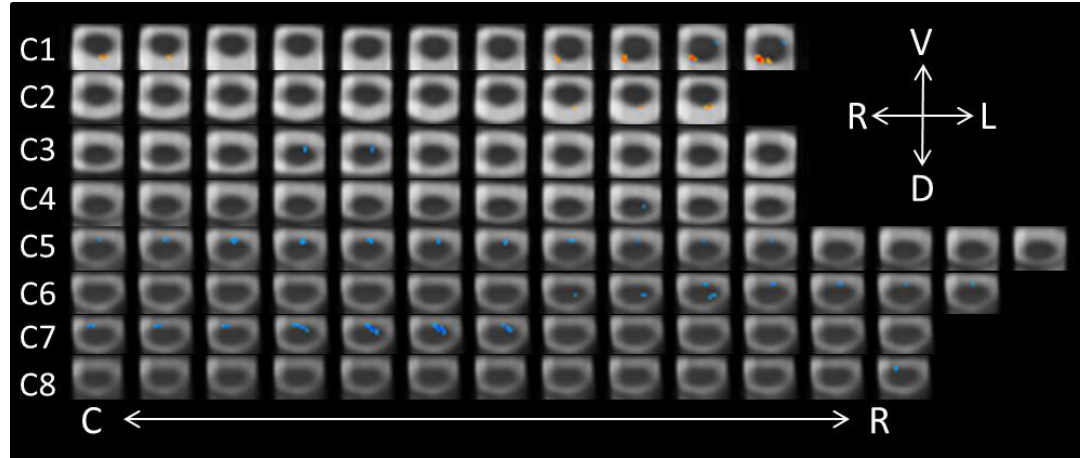
Figure 4. Axial spinal cord slices presenting the distribution of activity produced during the Neutral-unconscious/Anger-unconscious contrast (−1, 1). The images are oriented in radiological convention with dorsal towards the bottom of each frame, left side of the cord on the right of each frame, and are displayed caudal-to-rostral from left to right of each row (α = 0.00556). The abbreviations related to the axial directions (top-right of the figure) are defined as follows: R = right; L = left; V = ventral; D = dorsal. The abbreviations C and R (bottom of the figure) refer to caudal and rostral, respectively. Table 3. Location of spinal cord activity in the contrasts for the unconscious perception of neutral, angry, and fearful faces. Results are presented at p < 0.0056; results containing 1 or 2 voxels have been excluded as they are likely false positives.